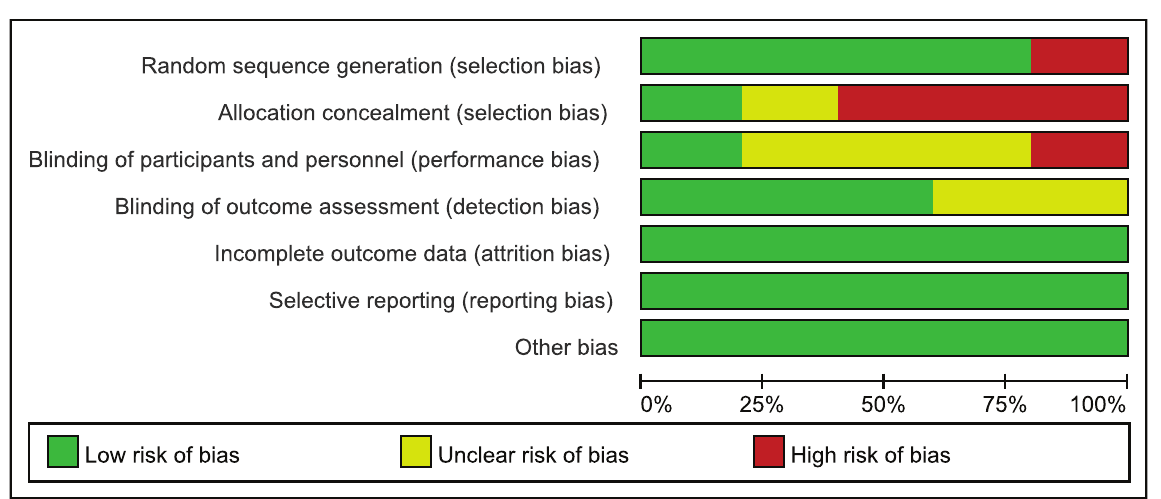
Figure 2. Risk of bias graph: reviewers’ judgments about each risk of bias item presented as percentages across all included